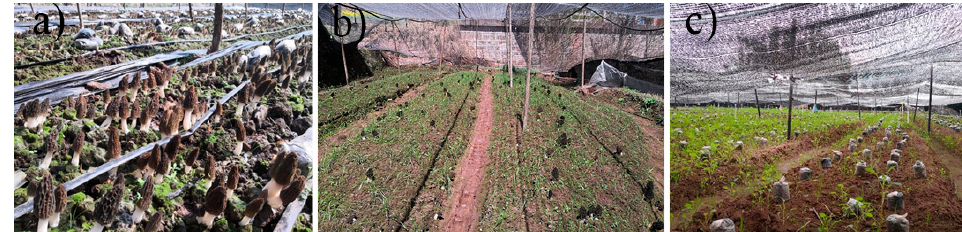
Figure 1. Soil samples of different morel production. Take site 1 in Songming as an example, ( a ) soil samples with high morel yield, ( b ) soil samples with low morel yield, ( c ) soil samples without morel yield.